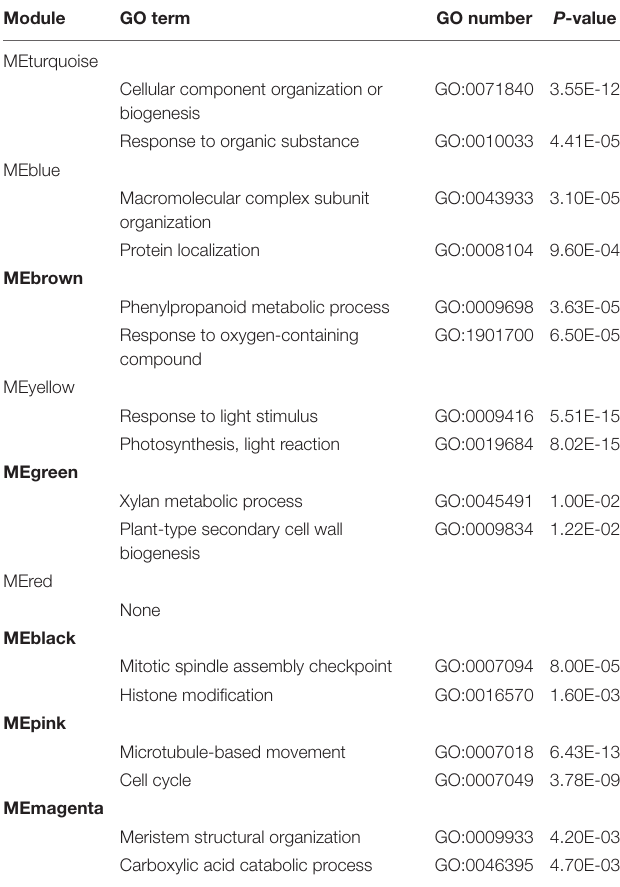
TABLE 1 | Gene Ontology (GO) enrichment of each